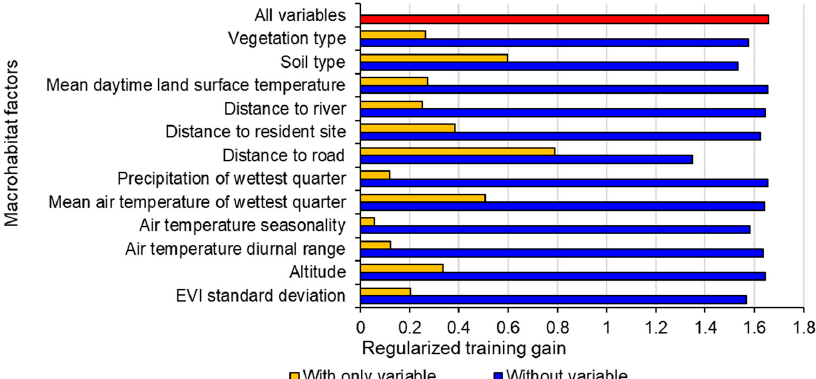
Figure 3. Importance of macrohabitat factors in modeling the distribution of plateau pika in the Qinghai Lake basin. “With only variable” indicates the results of the model when a single variable is run; “Without variable” indicates the effect of removing a single variable from the full model; “All variables” indicates the results of the model when all variables are run.